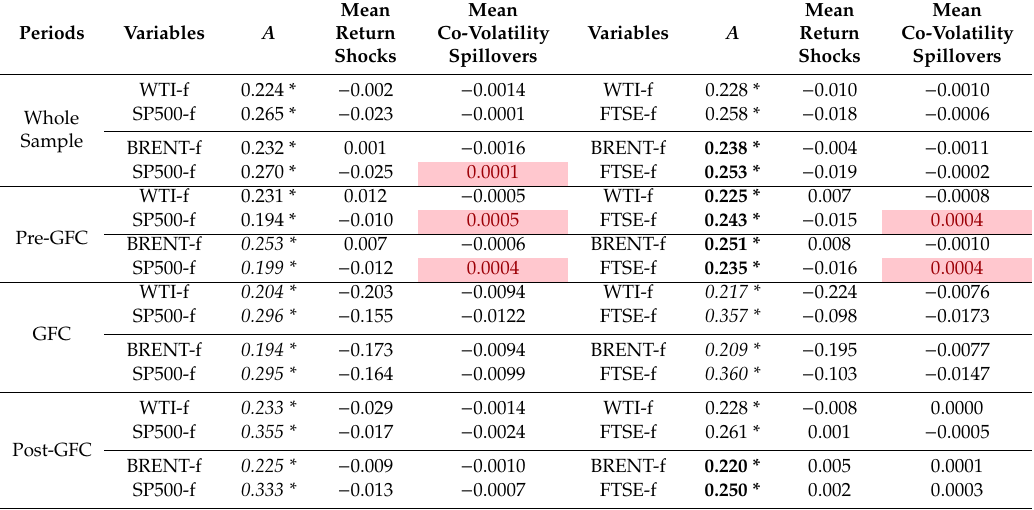
Table 6. Matrix A in Diagonal BEKK, mean return shocks, and mean co-volatility spillovers for the UK and US futures markets, four periods (2 ×